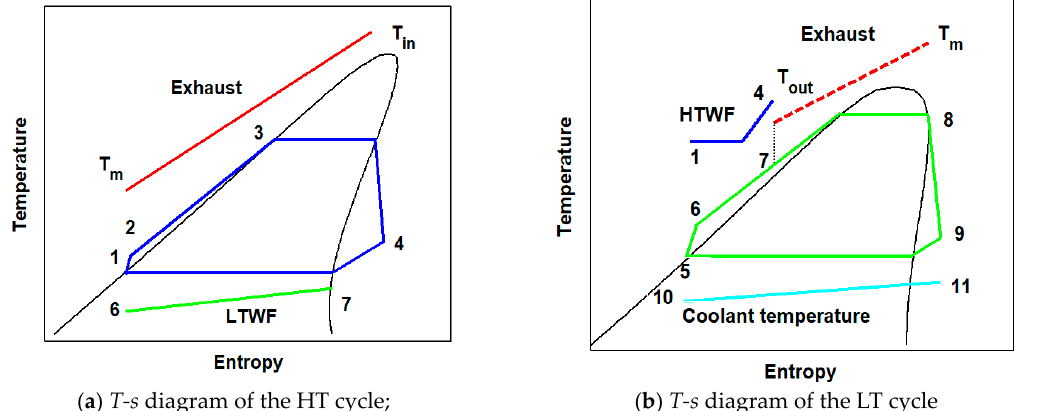
Figure 2. T-s diagrams of the HT cycle and LT cycle of the TLC-ORC.